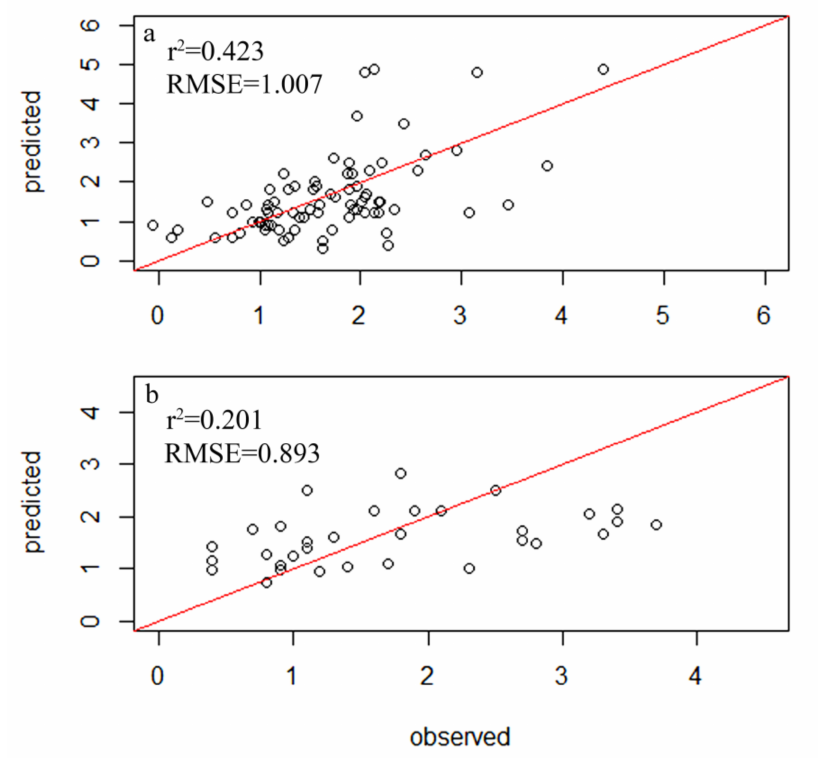
Figure 4. Relationship between the observed and diatom-inferred TN obtained via weighted averag- ing without tolerance down-weighting regression: ( a ) test group; ( b ) control